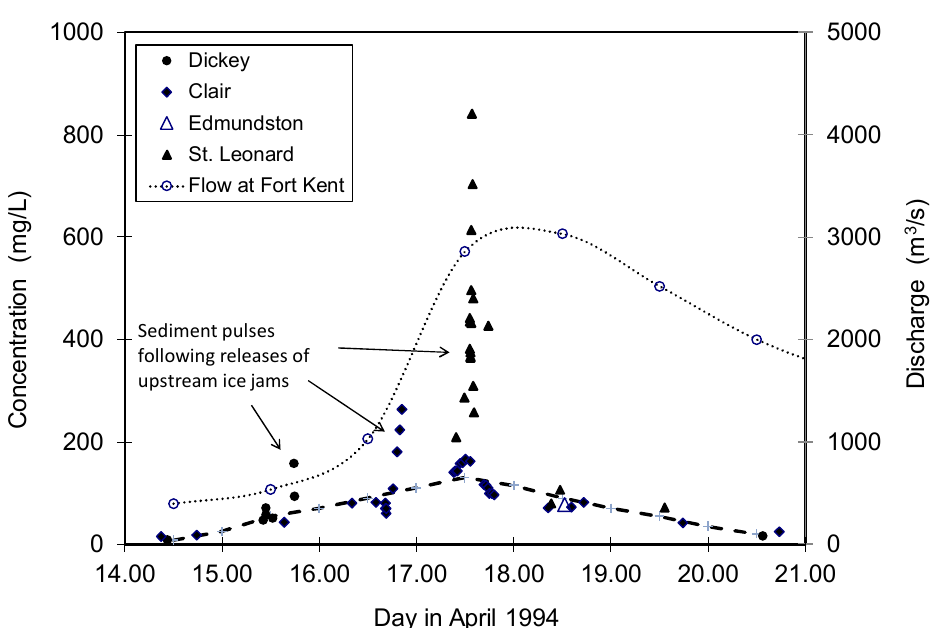
Figure 9. Suspended-sediment concentrations and mean daily flows during the 1994 breakup event in the upper Saint John River. The dashed line approximates the variation of “carrier” (no jave) concentration with time at a gauge located 1.3 km downstream of Clair. From [53], Crown copyright, published by Elsevier.